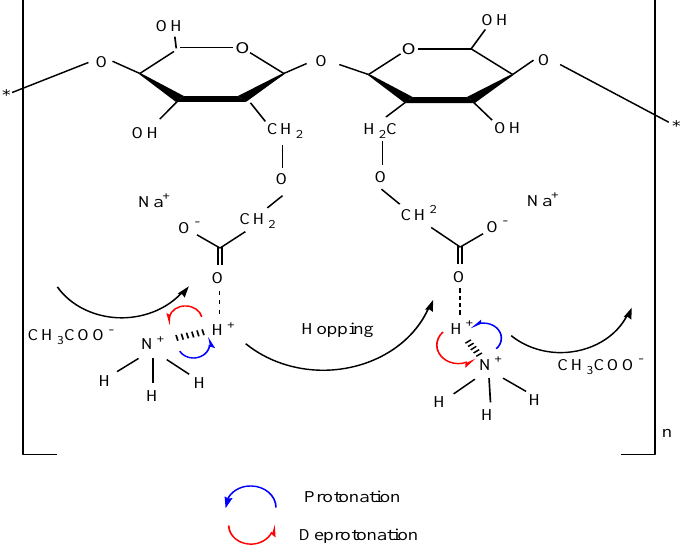
COONH via (N–H 4+ 3 4